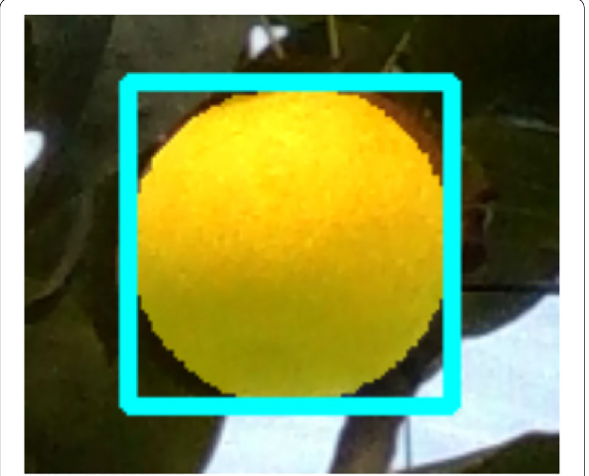
Fig. 6 Example of the detection result of Mask